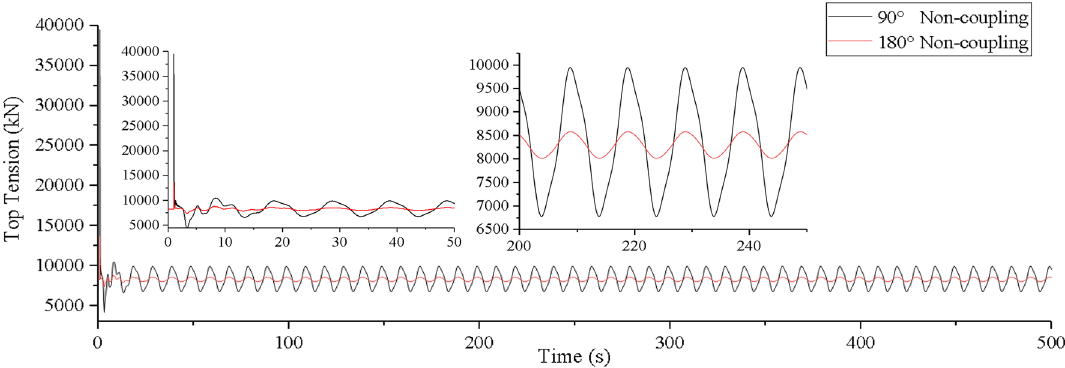
Figure 8. Time history curve of top tension of lifting pipe (created by Origin 2017 software, URL: https:// www. origi nlab. com/).